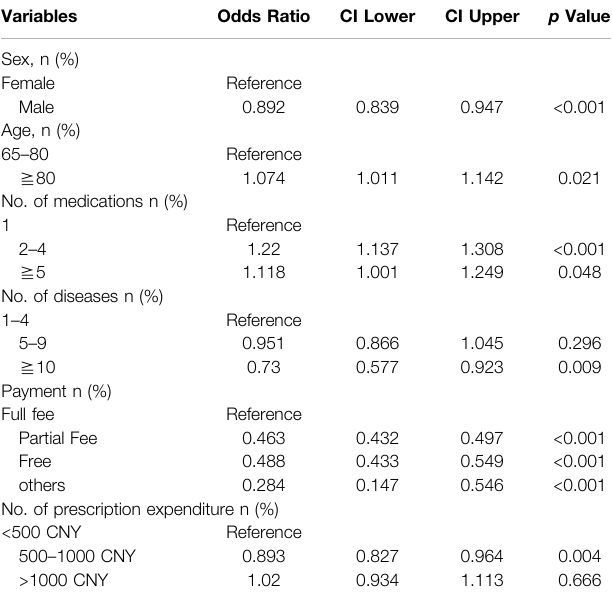
TABLE 2 | Multivariable analysis of risk factors associated with PIM among older outpatients with dementia in